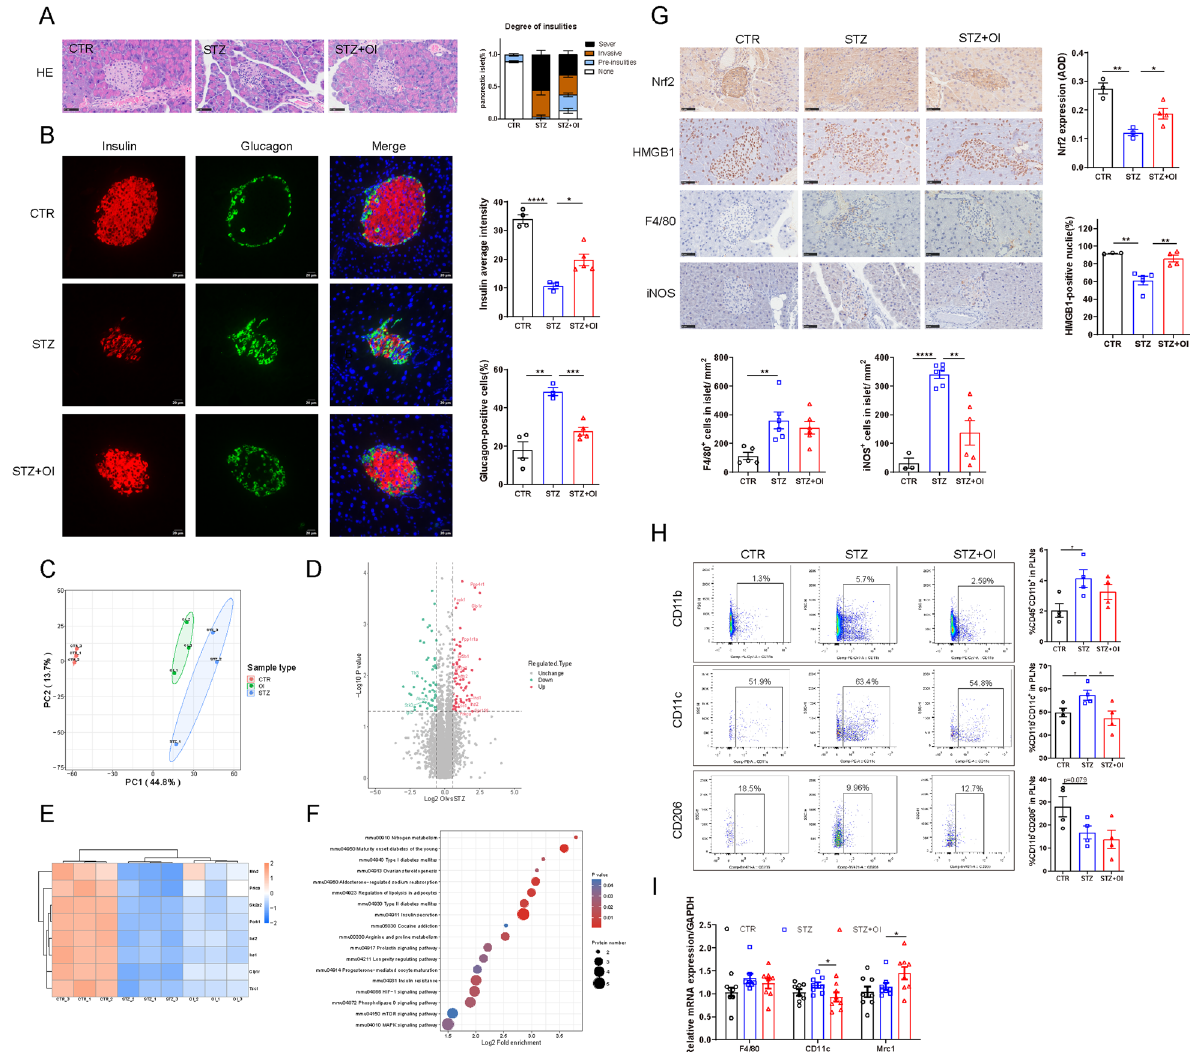
Fig. 2 OI attenuated insulitis, improved beta cell function, and suppressed inflammatory macrophage infiltration in STZ-induced diabetes. A Representative images of pancreatic histology evaluated by H&E staining ( n 5–8 mice per group). The scoring criteria were as described in the = ESM. B Representative images of pancreatic immunofluorescence staining for insulin (red), glucagon (green), and DAPI (blue). Insulin expression per islet was determined by analyzing fluorescence intensity with ImageJ. The percentage of glucagon-positive cells per islet was calculated in a bar graph ( n 3–5 mice per group). C Principal component analysis plot demonstrating the islet sample distribution in the control, STZ, and OI groups. = The plot displays three distinct clusters ( n 3 mice per group). D Volcano plot depicting the 130 DFEs identified in the STZ and OI islets. E Heat map = analysis illustrating the DFEs associated with islet beta cell function. The color change from blue to orange indicates low to high expression values. F List of Kyoto Encyclopedia of Genes and Genomes (KEGG) pathways significantly associated with the DFEs identified in the STZ and OI groups. G Immunohistochemistry analysis of Nrf2, HMGB1, F4/80, and iNOS expression in the mouse pancreas. Nrf2 expression was analyzed by ImageJ and presented as the Average Optical Density (AOD). The percentage of HMGB1-positive nuclei per islet was quantified in a bar graph. The F4/80- and iNOS-positive cells per islet area were calculated in a bar graph ( n 3–6 mice per group). H Flow cytometry assessment of the proportion of = 4 mice per group). I F4 / 80 , CD45 + CD11b + , CD11b + CD11c + , and CD11b + CD206 + macrophages in PLNs along with representative dot plots ( n = Cd11c , and Mrc1 gene expression in splenocytes ( n 8 mice per group). All values are the mean SEM. * p < 0.05. All values are shown as the = ± mean SEM. ** p < 0.01, *** p < 0.001, and **** p < ±